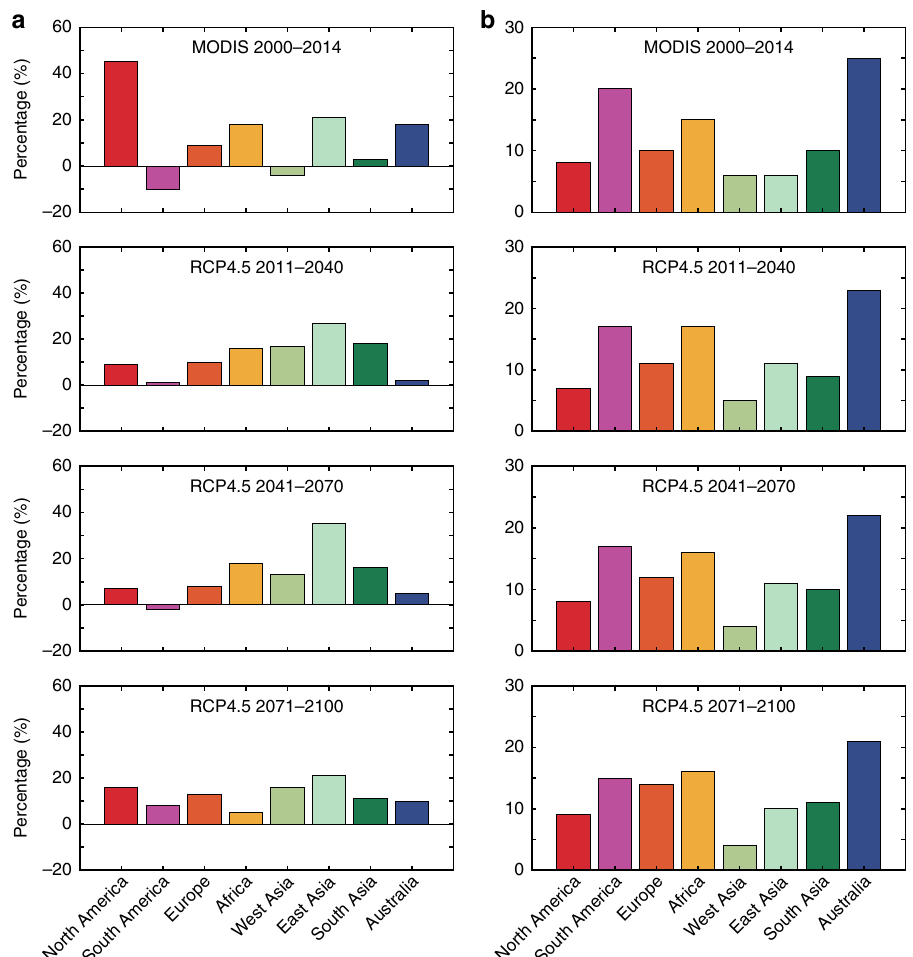
Fig. 2 Contributions from the eight regions to global dryland GPP. a Gross primary production (GPP) trend and b interannual variability (IAV) for 2000 – 2014 (MODIS) and during the three periods in 2011 – 2100